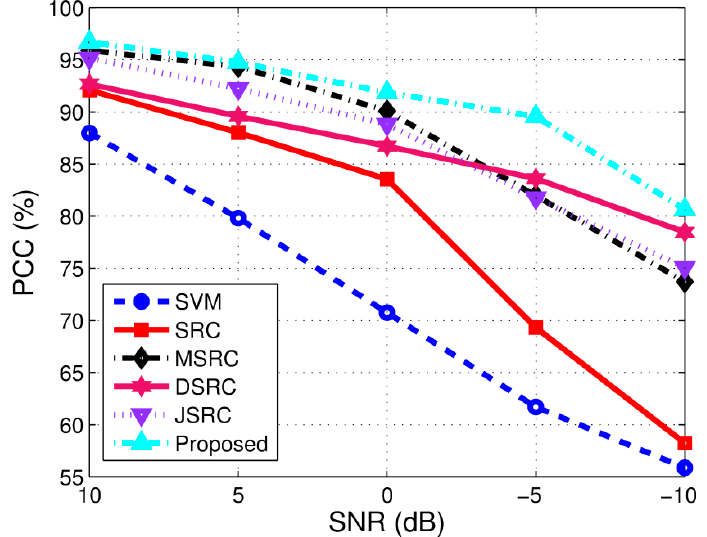
Figure 9. The PCCs of different methods under different noise levels.